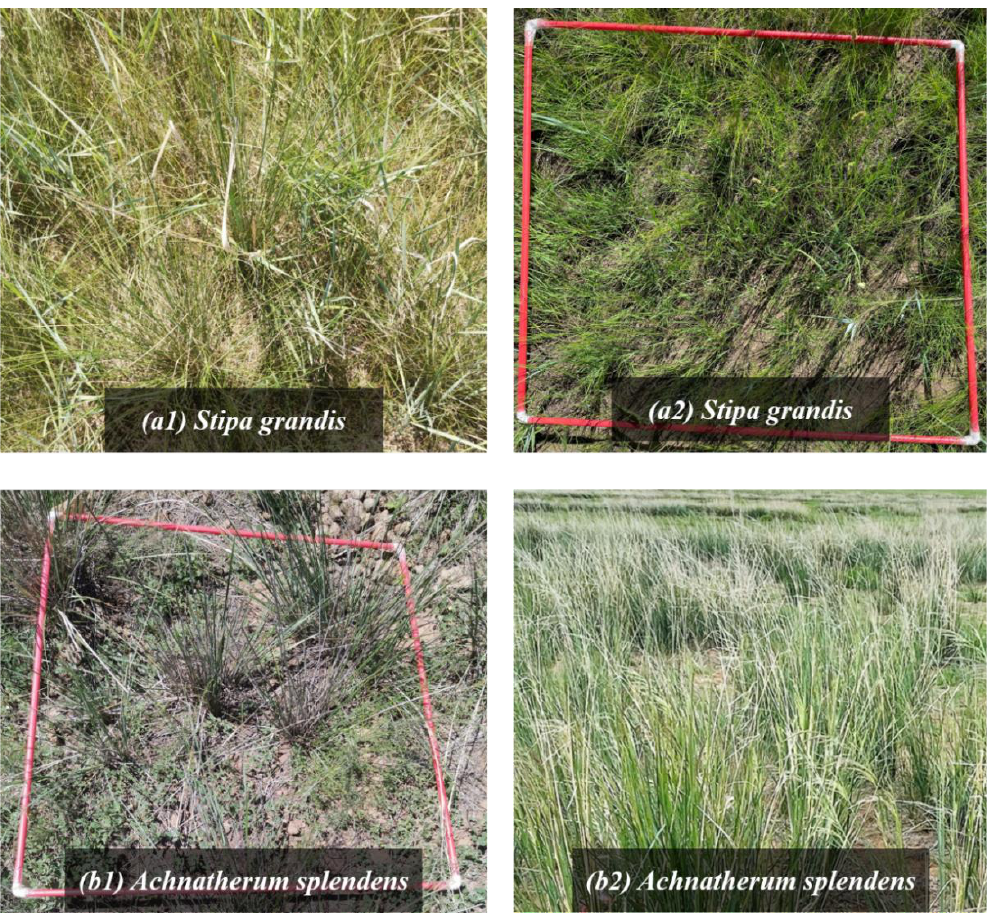
Figure 6. Photos for ( a1 , a2 ) Stipa grandis P.A. Smirn. and ( b1 , b2 ) Achnatherum splendens from the filed investigation in 2021.